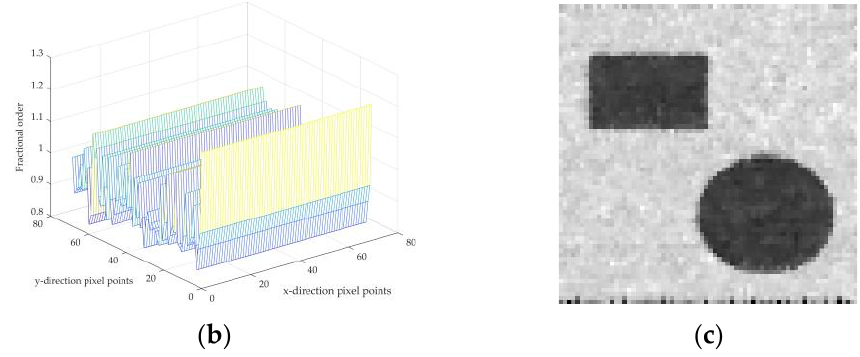
Figure 3. ISAFTV algorithm simulation example. ( a ) Step 1 input noisy image. ( b ) Step 6 output of order matrix visualization image. ( c ) Step 7 output processed image. Algorithm 1. Pseudocode for ISAFTV algorithm . Algorithm 1 ISAFTV